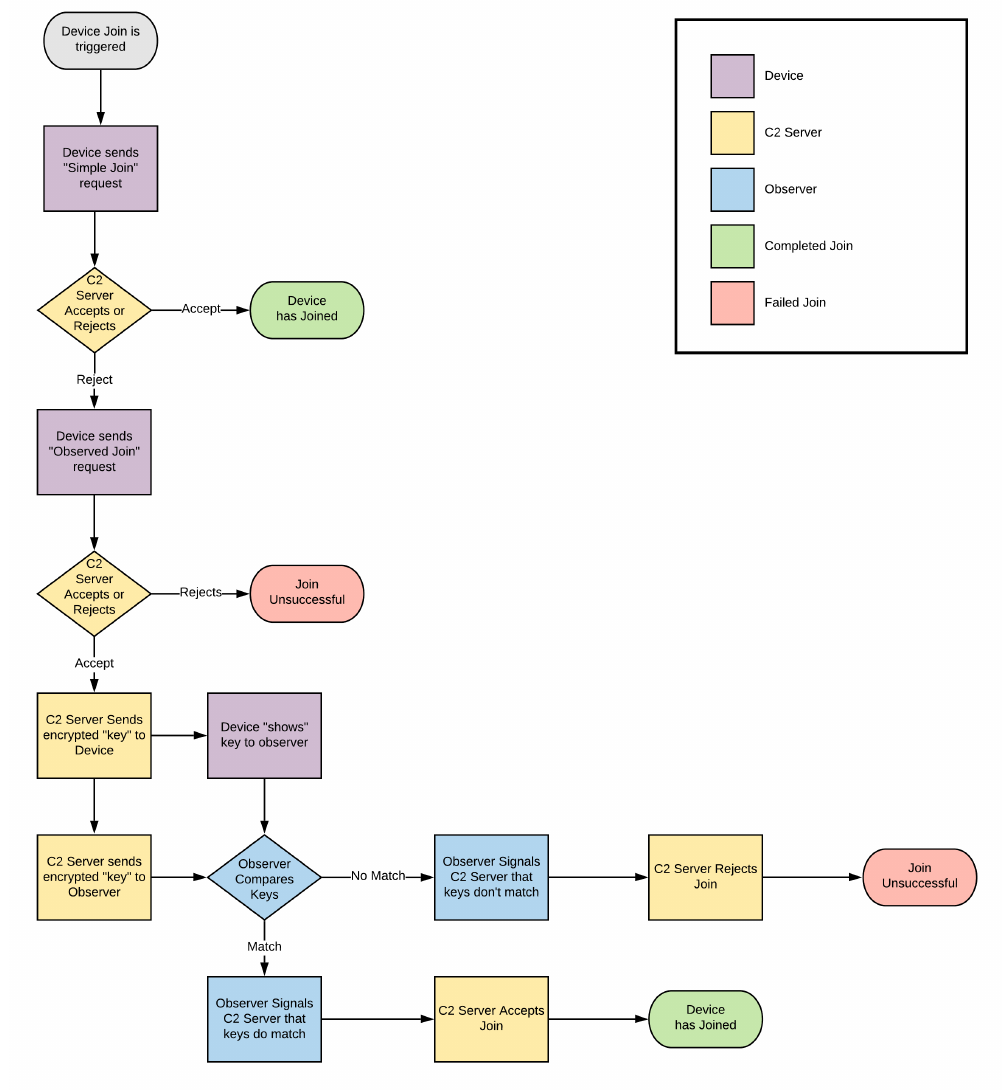
Figure 1. A flowchart illustrating the observed join process: showing the roles of each of the three entities